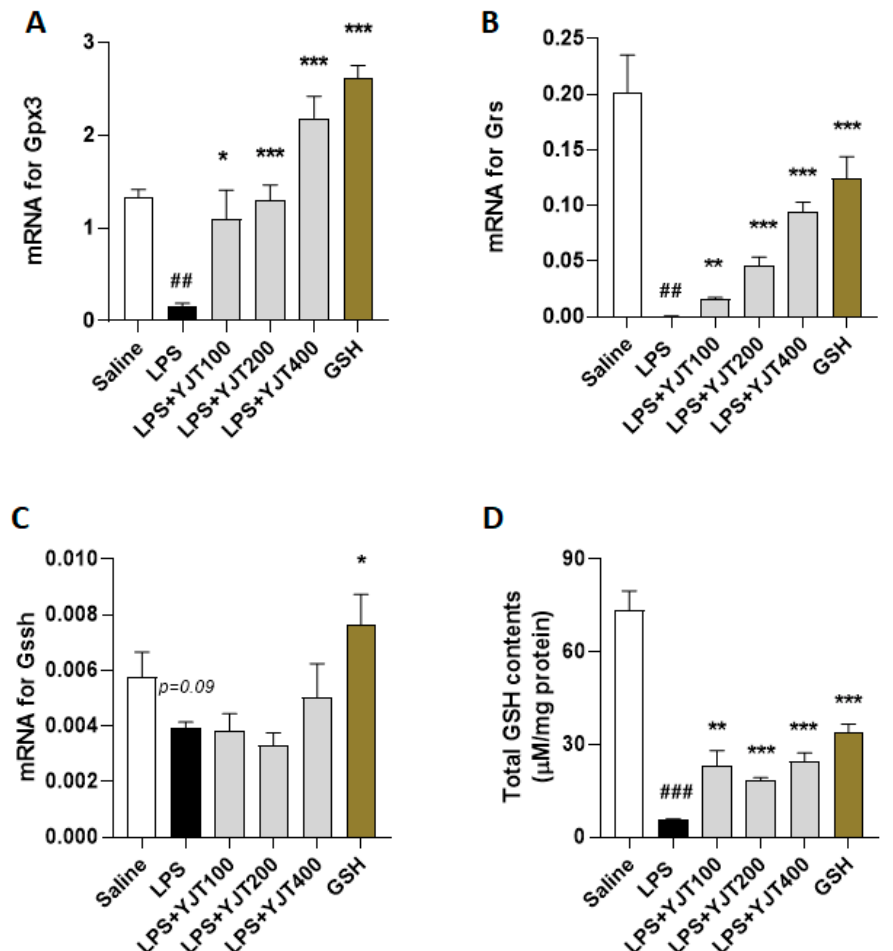
Figure 5. Effects of YJT on glutathione redox cycles in the hippocampus. Mice were sacrificed and brain tissues were removed after the final LPS injection. The hippocampus was isolated from brain tissue and prepared protein lysates ( n = 6–9 to each group) or mRNA ( n = 4–6 to each group) samples. Gene expression analysis of ( A ) Gpx3 ( B ) Gsr, ( C ) Gssh, and ( D ) protein levels of total GSH contents were measured. The data were expressed as mean ± SEM. ## p < 0.01 and ### p < 0.001 for Con vs. LPS, * p < 0.05, ** p < 0.01, and *** p < 0.001 for LPS vs. drug–administrated groups.